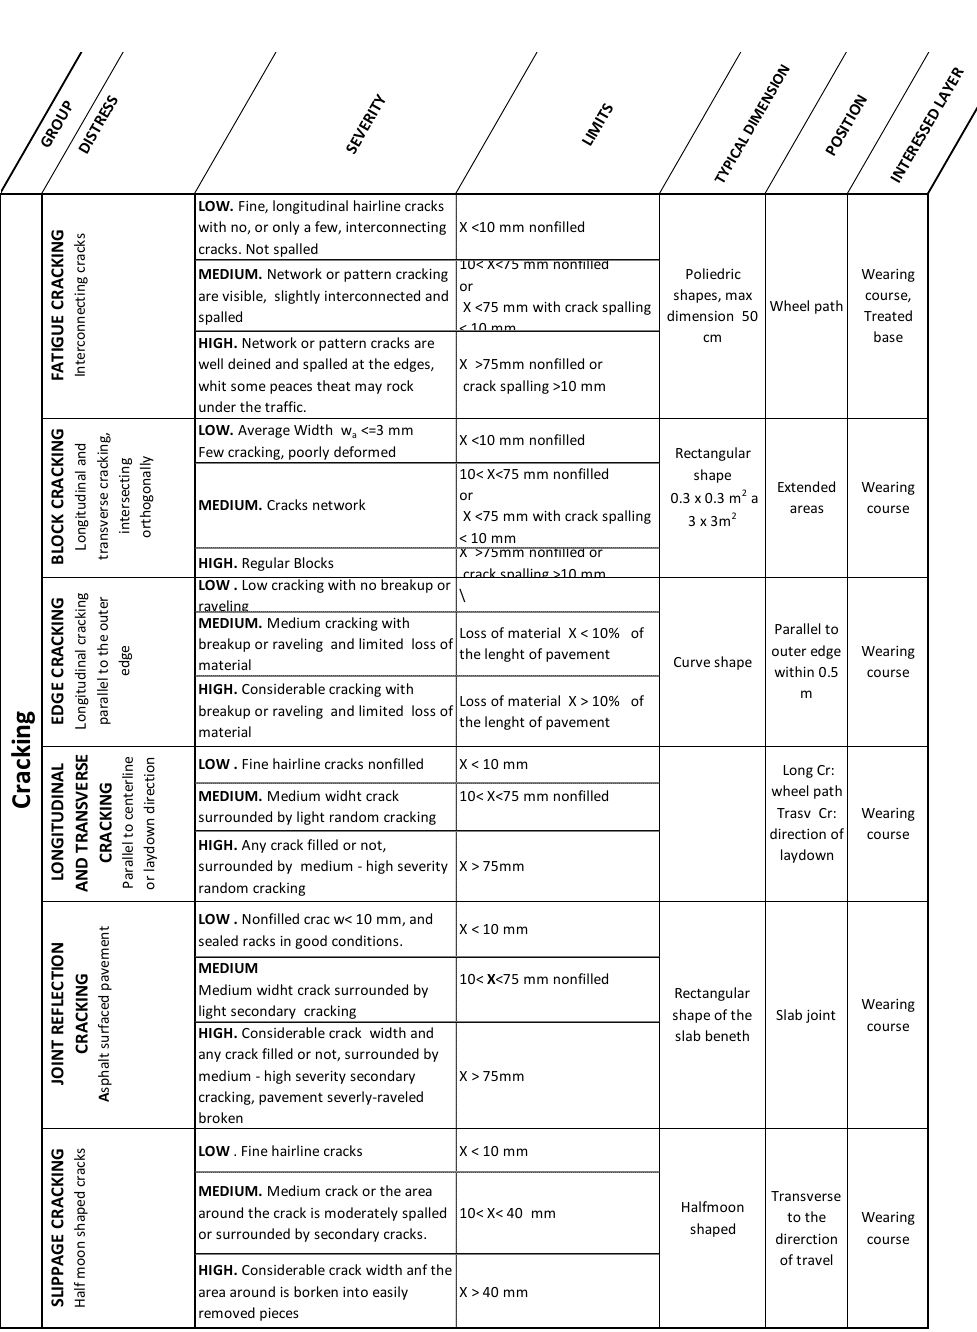
Figure A1. Cracking Group.